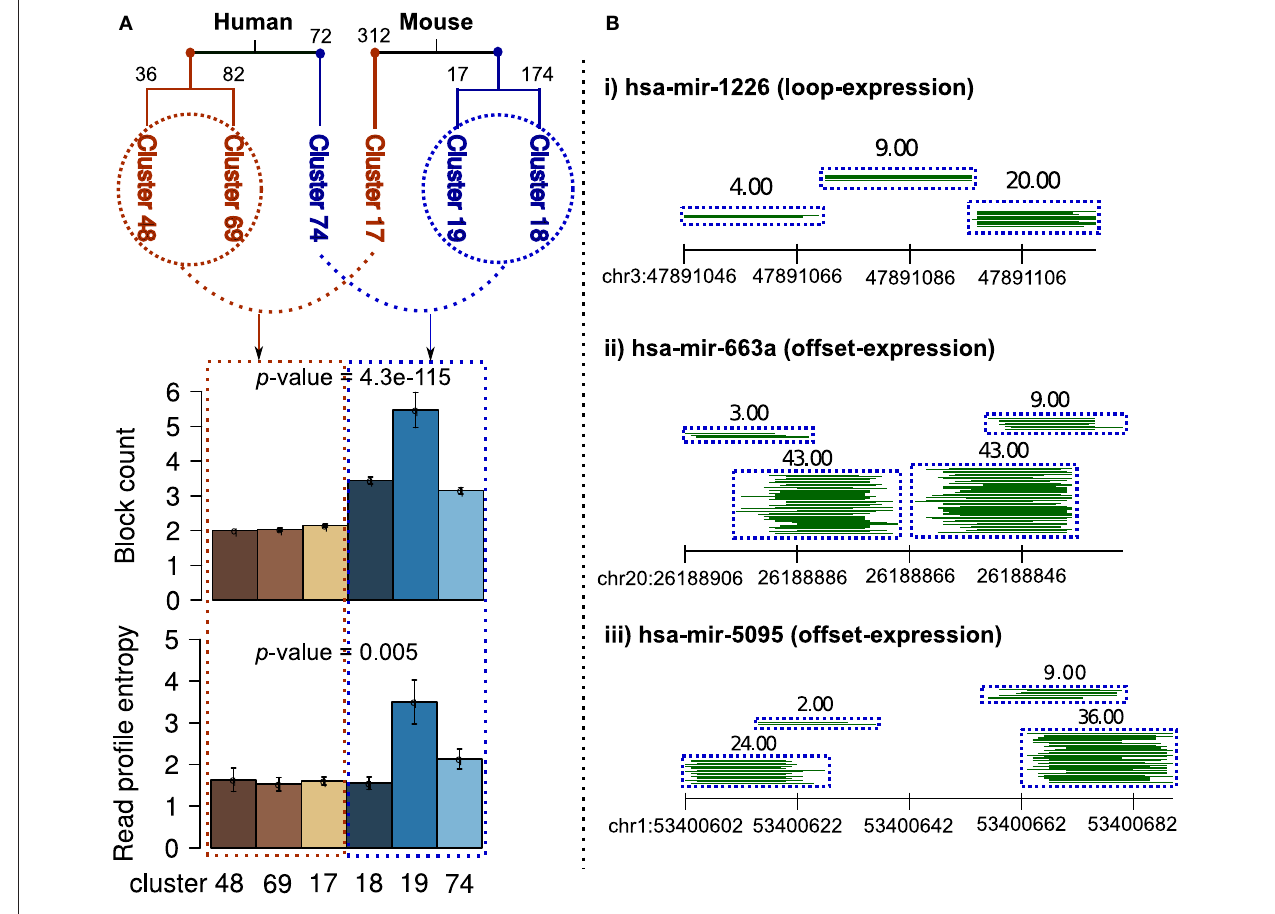
FIGURE 7 | Clusters of read profiles obtained after hierarchical clustering of 550 and 624 read profiles from Human and Mouse, respectively. (A) Two distinct and well-separated tree nodes were observed for both plant and animals (red and blue). For better representation, the count of read profiles within each cluster are shown on top of the corresponding branch. In comparison to read profiles in first node, read profiles in second node were characterized by a significantly high number of read blocks ( p -value = 4.3e-115, Fisher’s exact test) and entropy ( p -value = 0.005, Fisher’s exact